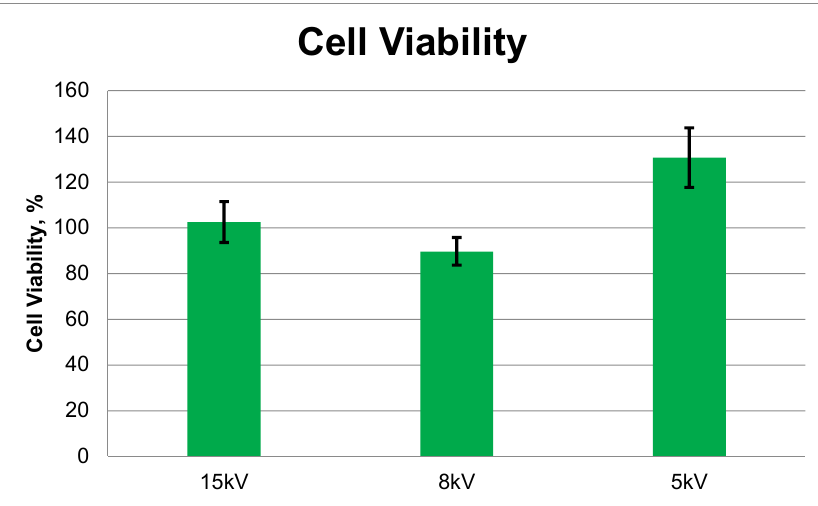
Figure 4. Cell viability measured by MTT test for the solution extracted from PCL/PEO-Ti0.5-Ag-15 kV (denoted 15 kV), PCL/PEO-Ti0.3-Ag-8 kV (denoted 8 kV) and PCL/PEO-Ti0.3-Ag-5 kV. Data presented as mean ±